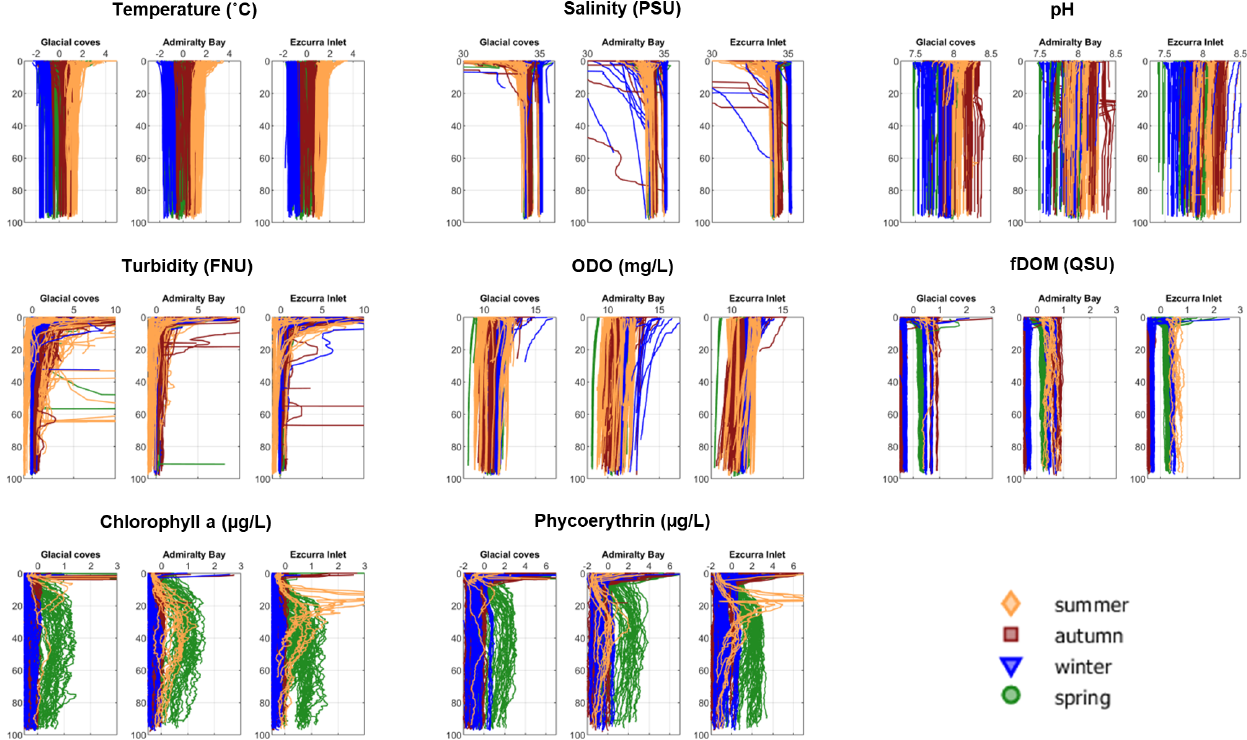
Figure 5. Vertical variability in measured properties divided by zone and